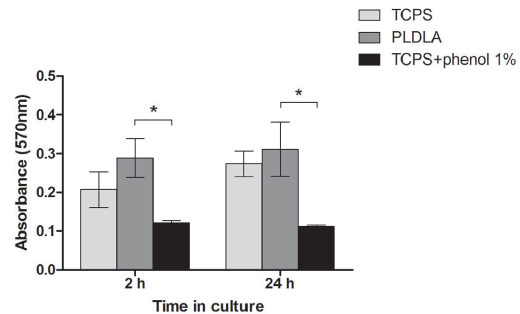
Figure 2. Viability of osteoblastic-like cells cultured on PLDLA scaffolds for 2 h and 24 h . Cell viability was assessed by the MTT assay and expressed as the absorbance of the purple formazan product indicative of viable cells . The positive control consisted of cells grown in TCPS wells without any additions, while the negative control consisted of cells exposed to 10% phenol. The columns are the mean ± SD of five independent experiments. *p<0.01 compared to the control and PLDLA groups.